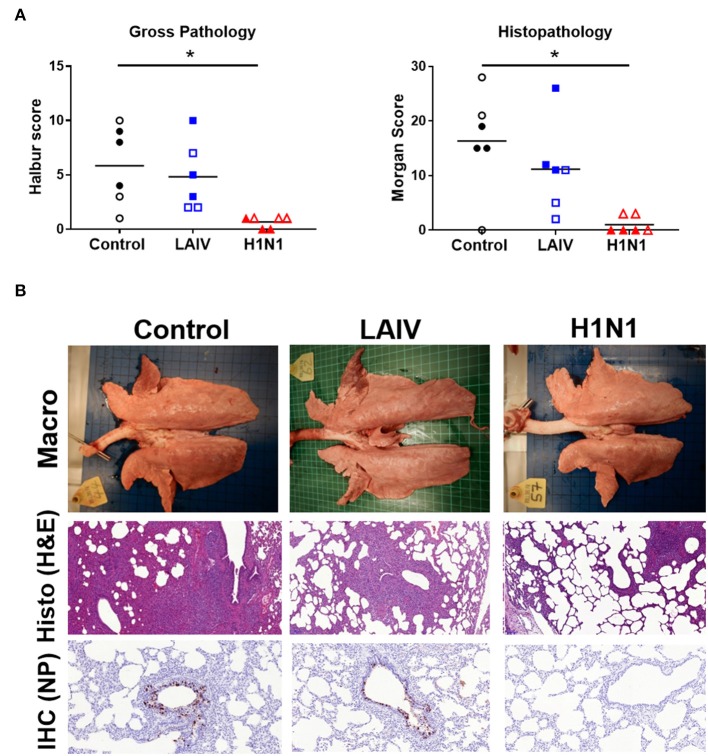
Lung pathology. Pigs were immunized with LAIV or infected with wt H1N1. Controls were untreated animals. Twenty-eight (filled symbols) or thirty-two (empty symbols) days later all animals were challenged with wt H1N1 and 4 days later culled. (A) Lung lesions at post-mortem were assessed macroscopically and microscopically. (B) Representative gross pathology, histopathology (H&E staining; 100x) and immunohistochemical NP staining (200x) of representative sections for each group are shown. Asterisks denote significant differences between the indicated groups. *p < 0.05 as analyzed by Kruskal–Wallis test. As the analysis of samples from pigs challenged at days 28 and 30 did not show any significant differences, for simplicity in presentation the results of the assays carried out on pigs challenged on both days have been amalgamated in this and the following figures.